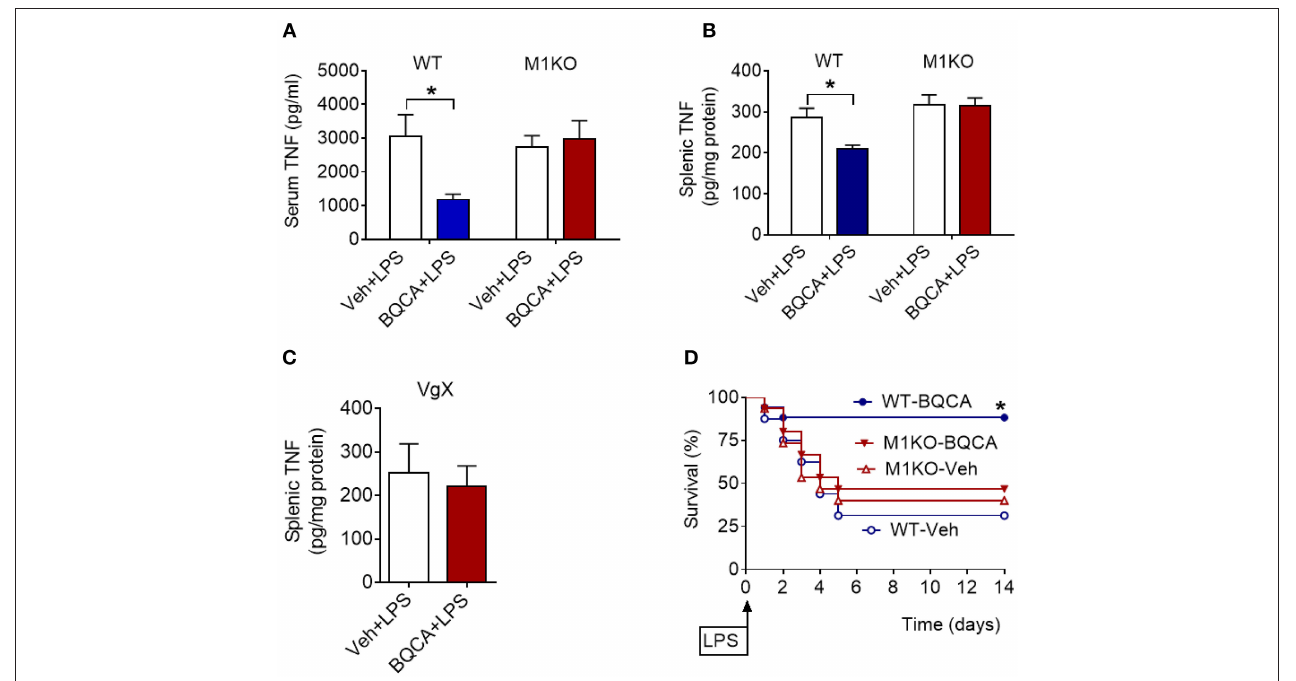
FIGURE 4 | Anti-inflammatory effects of BQCA in endotoxemia are mediated by M1 mAChRs. (A) Peripheral (i.p.) administration of BQCA (20 mg/kg, i.p.) suppresses serum TNF in wild type (WT) mice and does not alter serum TNF in M1 mAChR KO mice during endotoxemia (* P = 0.01, two-way ANOVA, Sidak’s multiple comparisons test), n = 8–10. (B) Peripheral (i.p.) administration of BQCA (20 mg/kg, i.p.) suppresses splenic TNF in WT mice and does not alter splenic TNF in M1 mAChR KO mice (* P = 0.017, two-way ANOVA, Sidak’s multiple comparisons test), n = 7–10. (C) Vagotomy (VgX) abolishes the effect of BQCA on splenic TNF during endotoxemia (unpaired two-tailed Student’s t test), n = 7, 8. (D) Peripheral (i.p.) administration of BQCA (20 mg/kg, i.p.) improves survival in endotoxemic WT mice and does not alter the survival rate in M1 mAChR KO mice during endotoxemia (* P = 0.028, Log-rank test), n = 15–18 per group. See Methods for